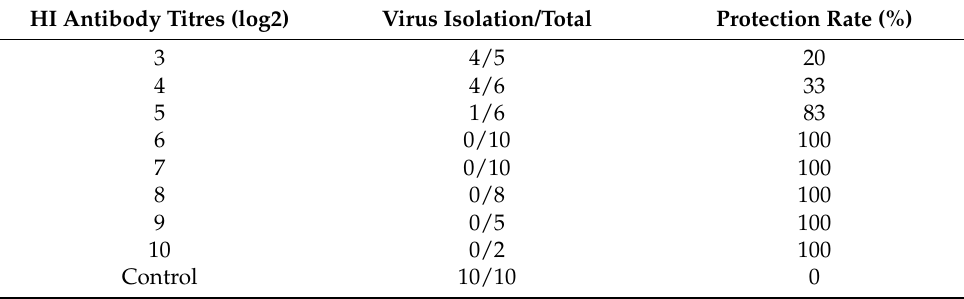
Table 1. Protective efficacy against H9N2 challenge in